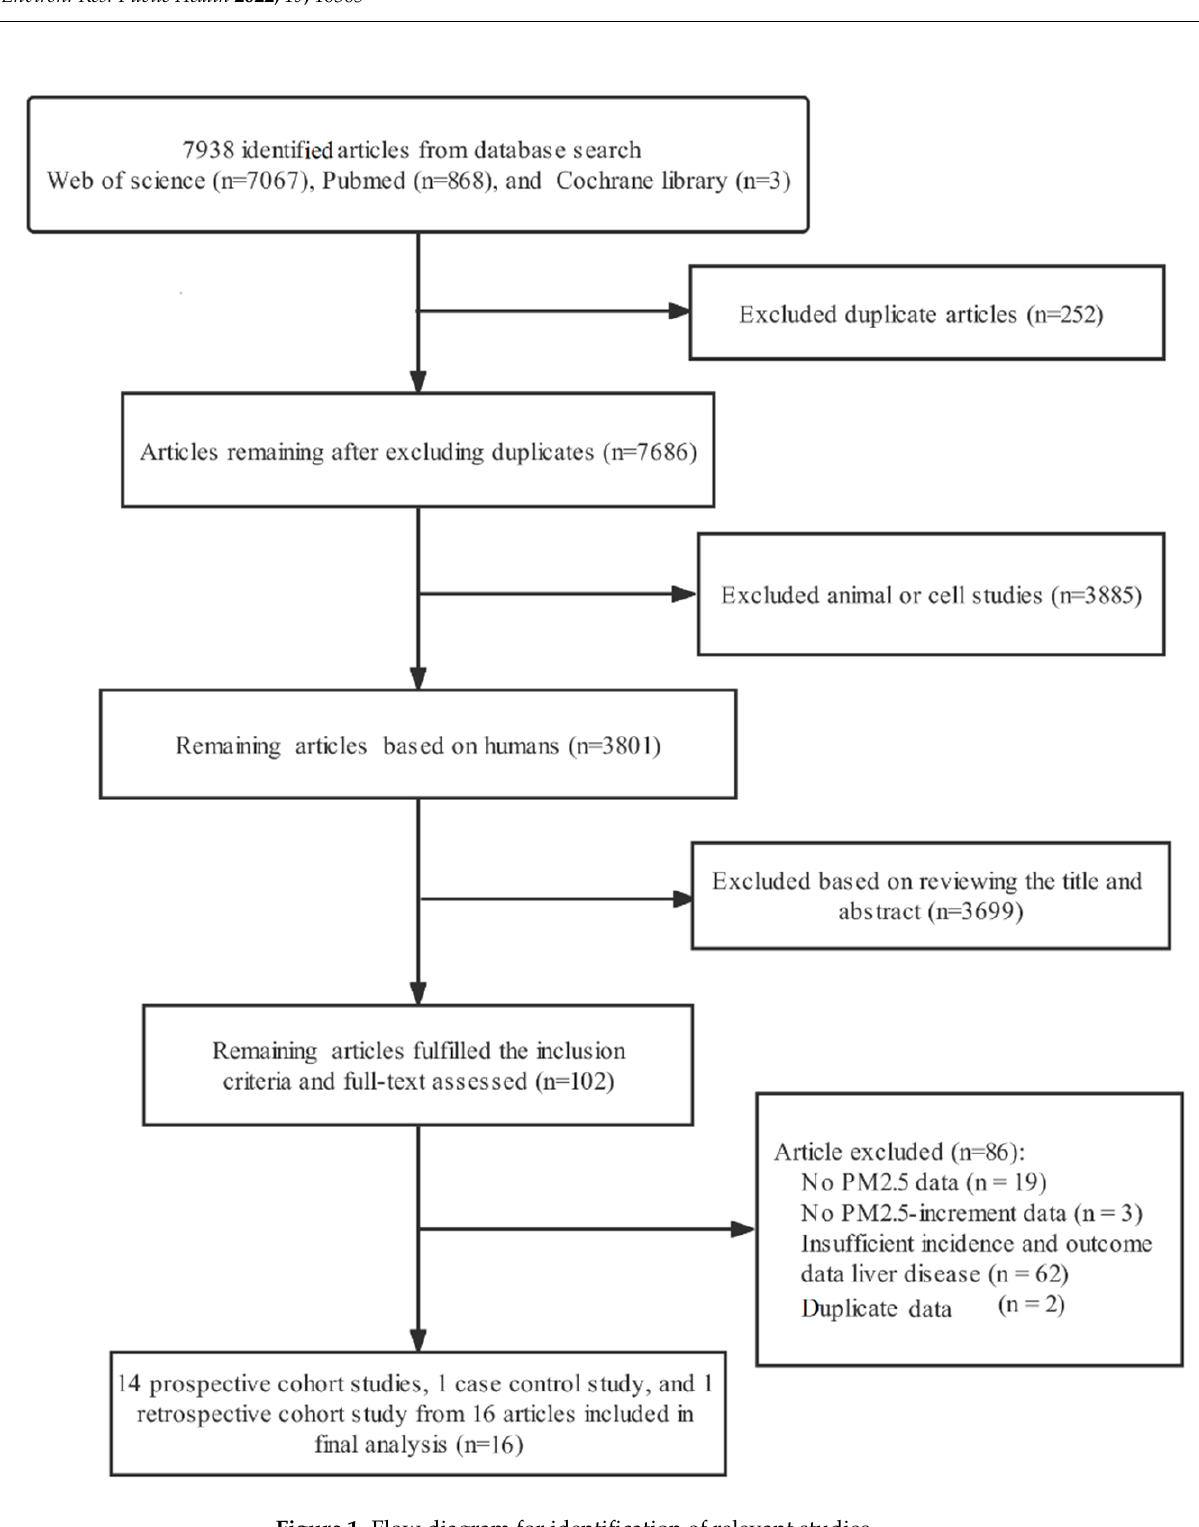
Figure 1. Flow diagram for identification of relevant studies.